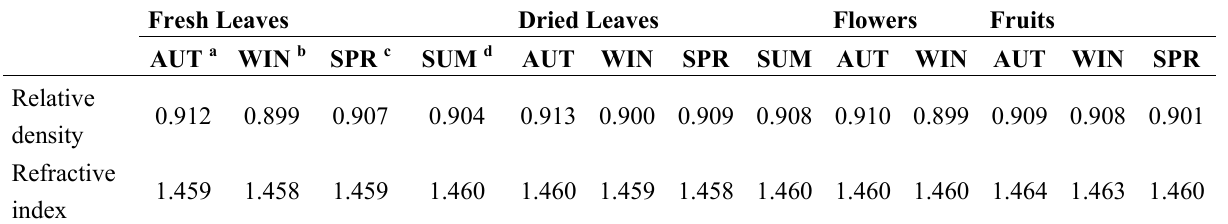
Table 1. Relative density and refractive index of essential oils from leaves, flowers and fruits of Eucalyptus cinerea . Fresh Leaves Dried Leaves Flowers Fruits